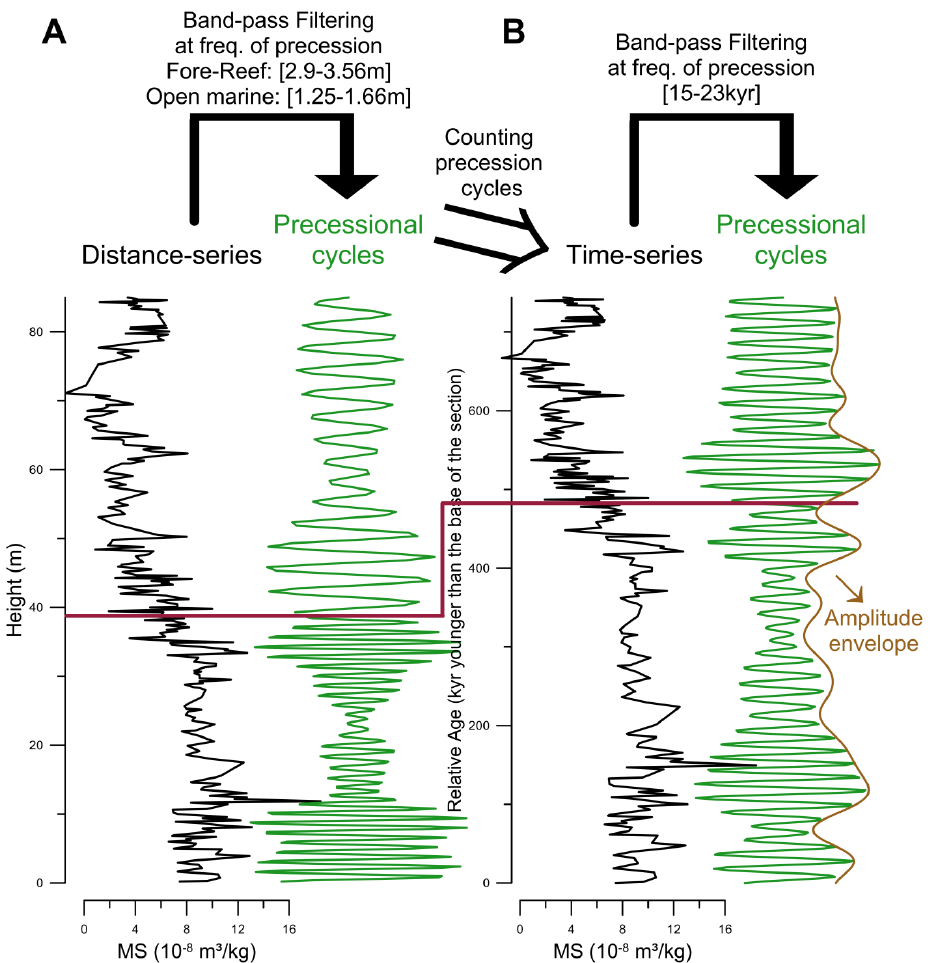
Fig. 4. From distance-series to time-series. (A) : Magnetic Susceptibility series of the “La Couvinoise” section plotted against a distance-axis (black) and band-pass filtered Magnetic Susceptibility signal at the frequencies of precession (green, band-pass filtered between 1.25–1.66m in the lower part and between 2.9–3.56m in the upper part of the section). (B) : Magnetic Susceptibility series of the “La Couvinoise” section plotted against a time-axis (black) and band-pass filtered Magnetic Susceptibility signal at the frequency of precession (band-pass filtered between 15 and 23kyr; green)+amplitude envelope of the precessional signal (brown).